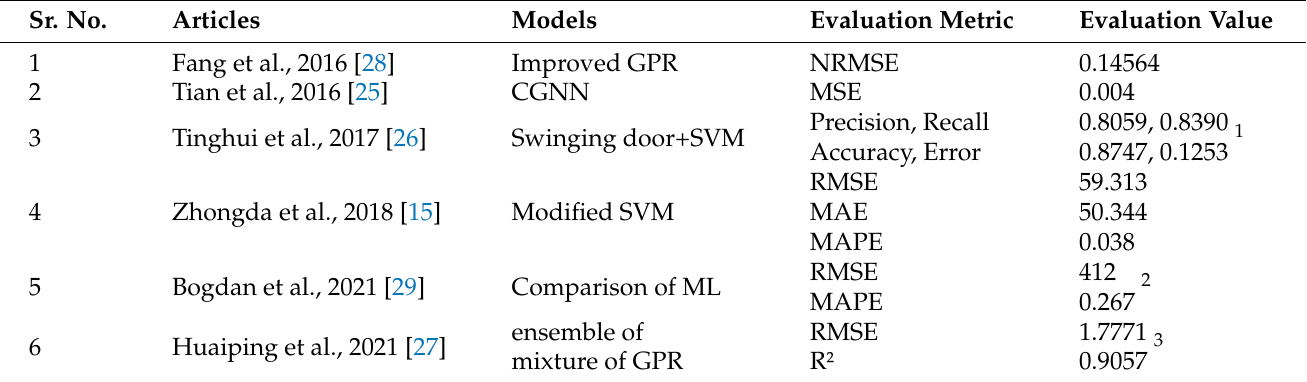
Table 3. Machine learning methods for long term